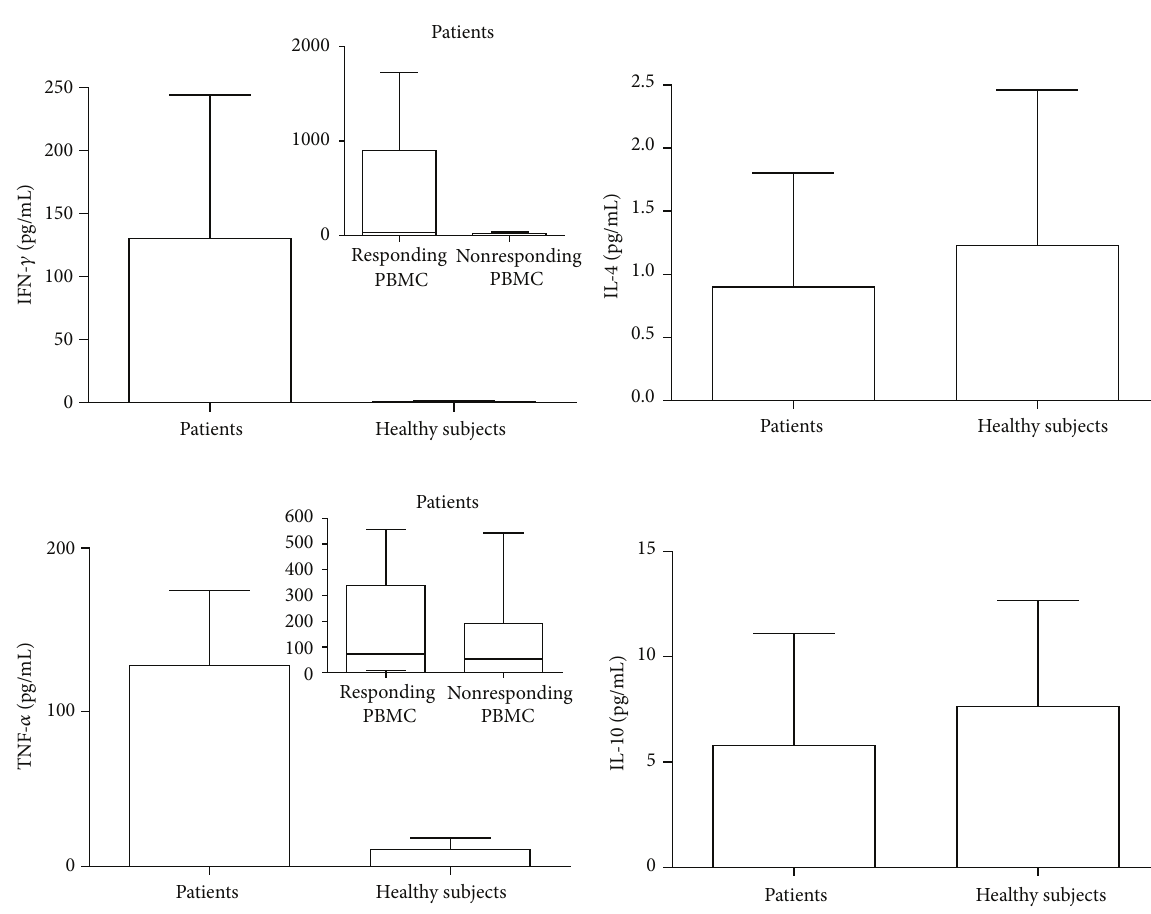
Figure 3: Cytokine secretion in culture supernatants from patients’ and healthy subjects’ peripheral blood mononuclear cell (PBMC)samples; IFN- 𝛾 and TNF- 𝛼 production by patients’ PBMC responding or not to actin in proliferation assay.